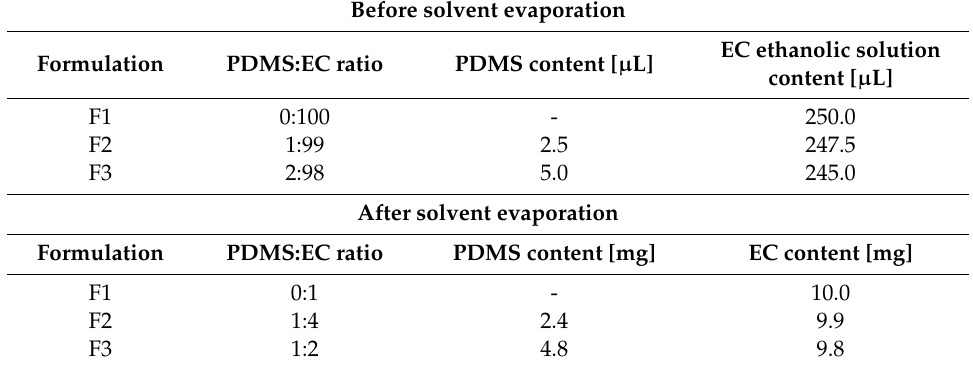
Table 1. Composition of each formulation (F1–F3) with PDMS:EC ratio before ( v / v ) and after solvent evaporation ( w / w